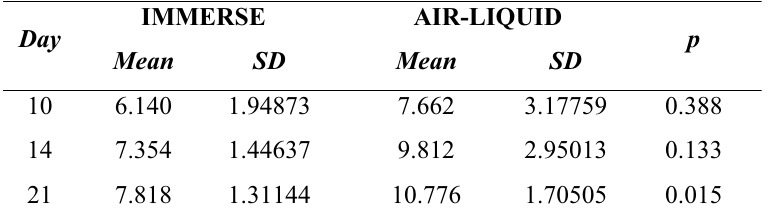
TABLE 1 – Mean values of counted keratinocyte nuclei (cells) viewed in 10 consecutive fields throughout the duration of the experiments in immerse and in air-liquid interface cultures